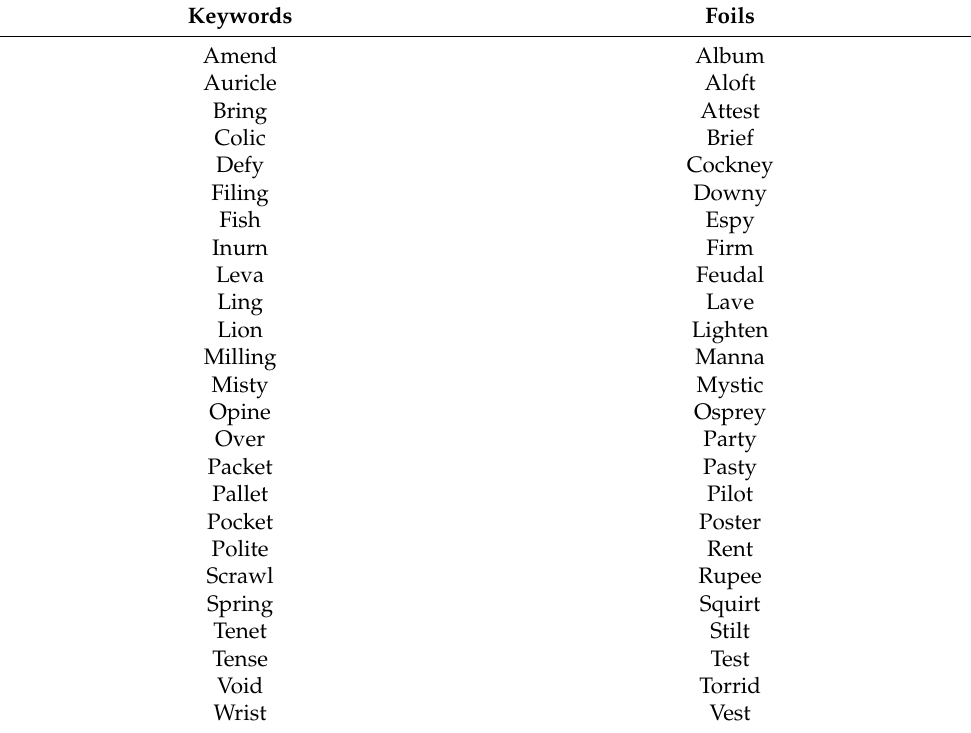
Table A3. Stimulus words from Vitevitch and Goldstein (2014) that were used in Simulation 3a,b.